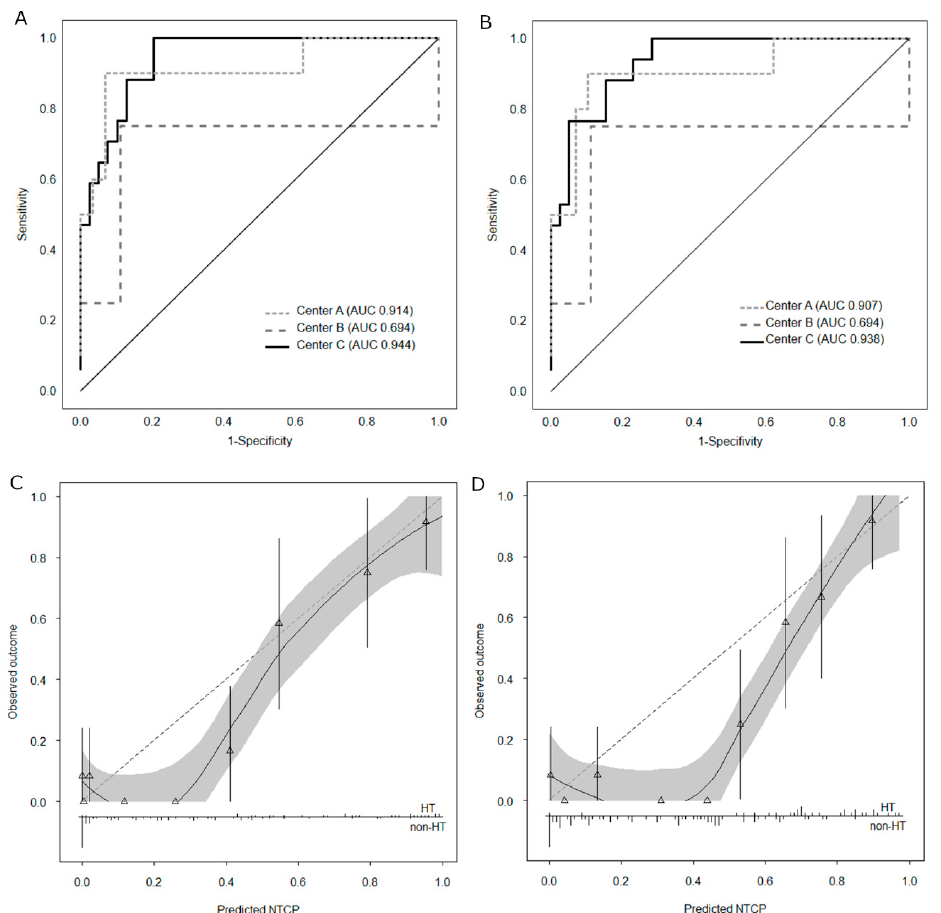
Figure 2. Validation of radiation-induced hypothyroidism (RIHT) predictions using the model by Rønjom et al. (left) and Boomsma et al. (right). ( A ) Receiver operating characteristic curves for each center for the model by Rønjom et al.; areas under the curve given in parentheses. ( B ) Receiver operating characteristic curves for each center for the model by Boomsma et al. ( C ) Calibration plot for the model by Rønjom et al. for all patients combined. Predictions for a perfect model would be close to the dashed reference line. The triangles represent grouped predicted probabilities (NTCP scores) vs. grouped observed frequencies of RIHT; vertical lines represent 95% confidence intervals. The loess smoothing algorithm was used to estimate the observed RIHT probabilities in relation to predicted probabilities; this function is displayed with a solid black line. The distribution of predictions in patients with / without hypothyroidism (HT) is plotted at the bottom of the graph. ( D ) Calibration plot for the model by Boomsma et al. for all patients combined. Abbreviations: NTCP = normal-tissue complication probability; AUC = area under the curve; HT = hypothyroidism RIHT = radiation-induced hypothyroidism.